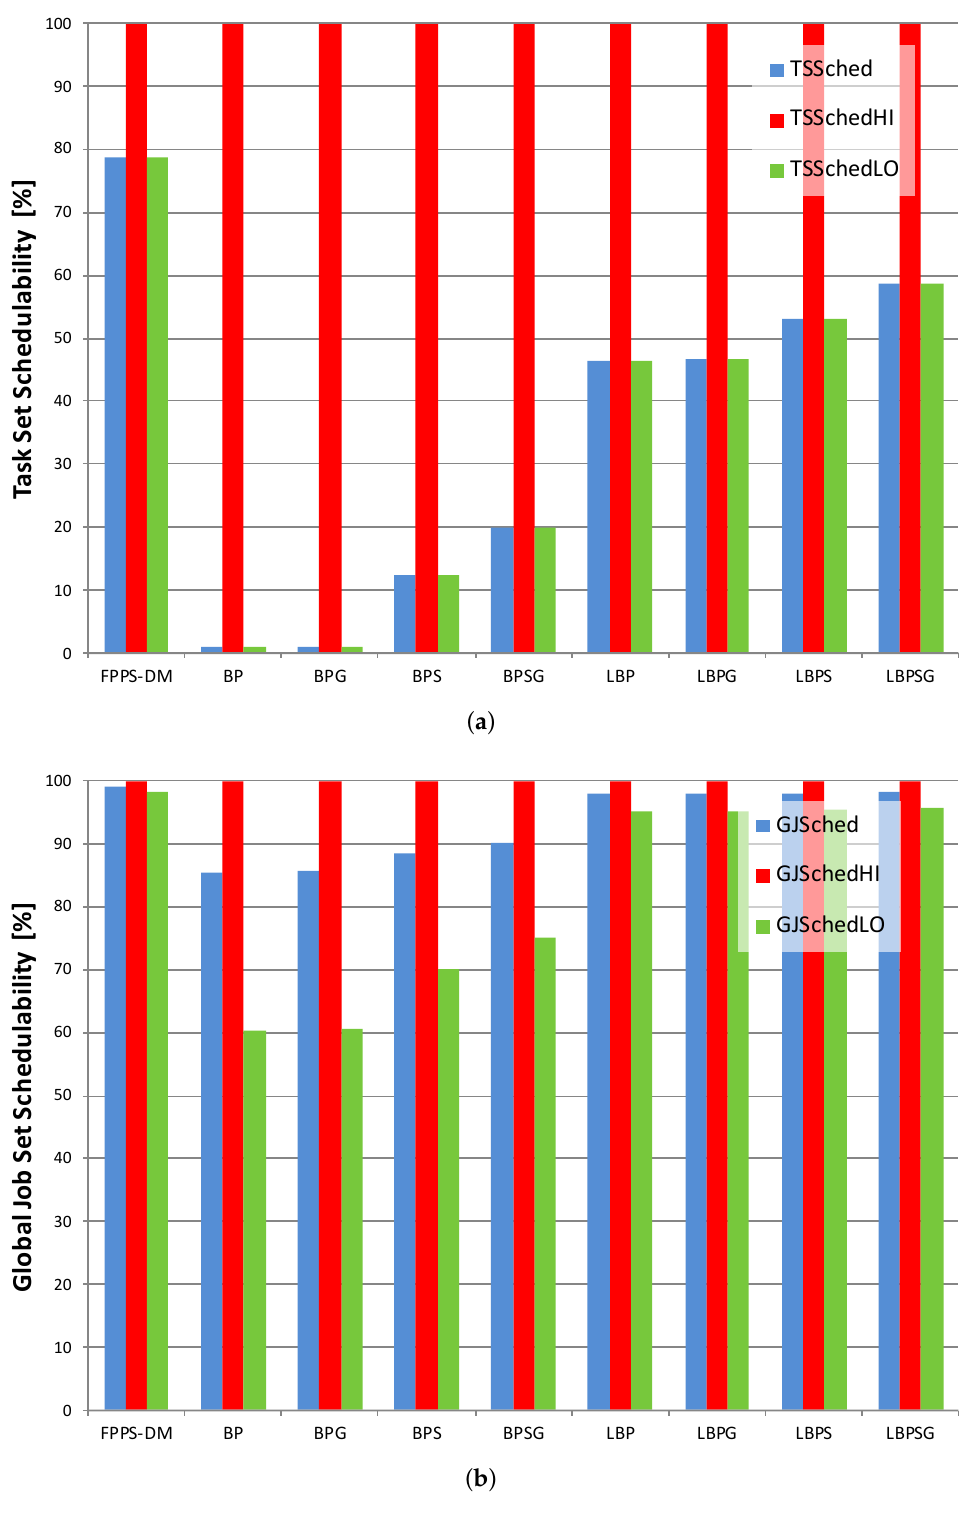
Figure 9. BP and LBP variants: schedulability in HC-HP scenario (as priority and criticality values have the same order, this is essentially a standard real-time scheduling problem): ( a ) task sets with no jobs missed; and ( b ) average of jobs scheduled per task